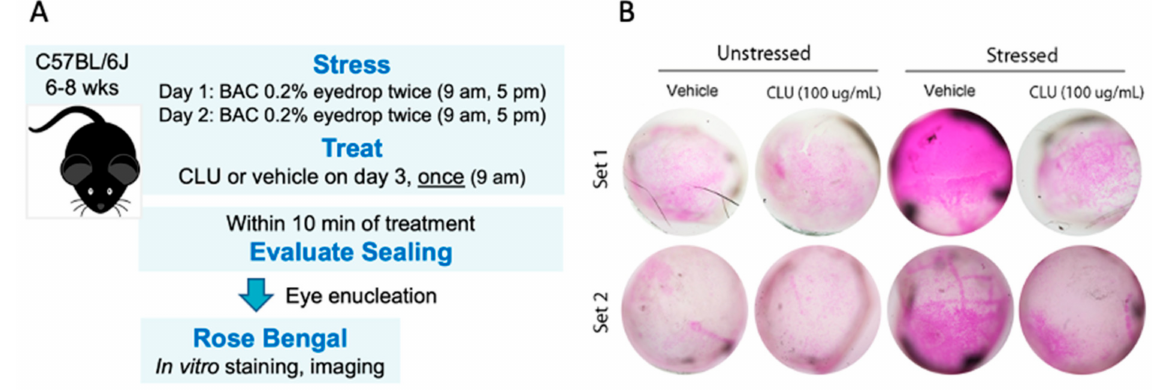
Figure 1. CLU seals the ocular surface barrier damaged by BAC. ( A ) One drop of a BAC solution (0.2% dissolved in PBS) was applied to the ocular surface twice (9 a.m., 5 p.m.) on day 1, and twice (9 a.m., 5 p.m.) on day 2. On the morning of day 3, the ocular surface was treated with a drop of CLU (100 µ g/mL), or with vehicle alone (PBS). For comparison, unstressed eyes were similarly treated. Ten minutes after CLU treatment, eyes were enucleated and sealing was evaluated by in vitro rose bengal staining and imaging. ( B ) Images of enucleated eyes stained with rose bengal. The experiment was performed in duplicate (Set 1 and Set